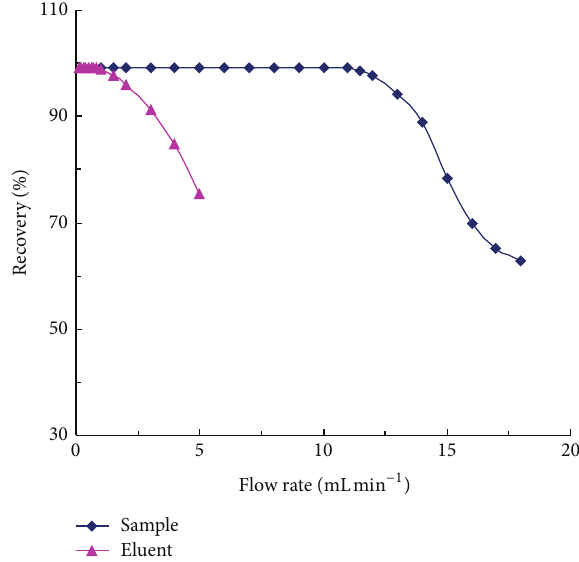
Figure 6: Effect of sample and eluent flow rates on the recovery of U(VI) using 1L of model solution of 10 𝜇 g L −1 U(VI), eluting with 5 mL eluent solution of 0.50M HCl. The data presented are the average of five experiments.